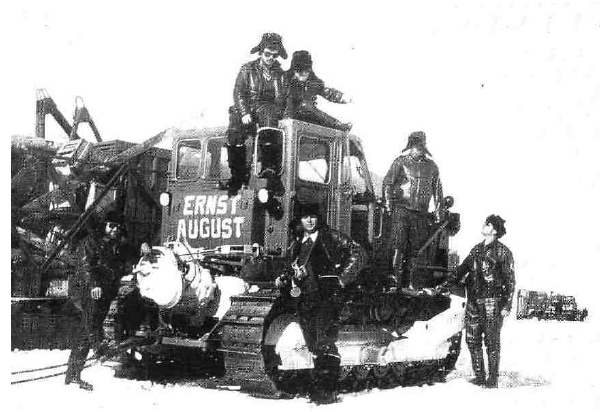
Figure 31. Unloading upon the Antarctic ice shelf.